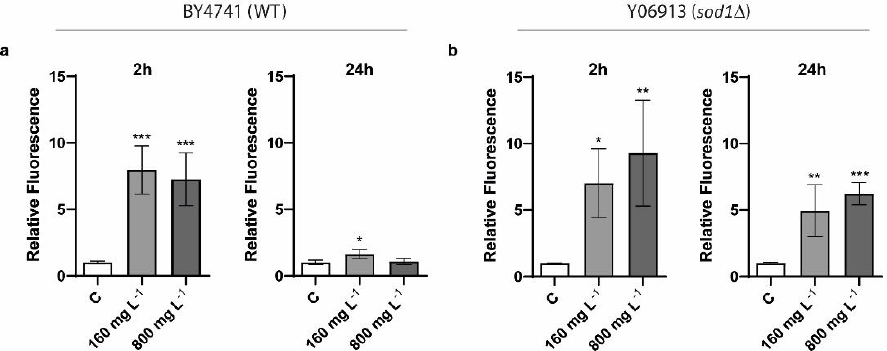
Figure 4. Reactive oxygen species (ROS) levels determination of S. cerevisiae cells exposed to 160 and 800 mg L −1 of CNTs during 2 h ( a ) and 24 h ( b ) in BY4741 (WT) and Y06913 ( sod1 ∆) strains. The control condition (C) corresponds to non-exposed S. cerevisiae cells. The reported values are the averages of four biological replicates per culture condition. Differences were established using a One-way ANOVA followed by Tukey´s multiple comparisons test, to compare every mean with the control and considered significant at p ≤ 0.05. * p ≤ 0.05, ** p ≤ 0.01, *** p ≤ 0.005.